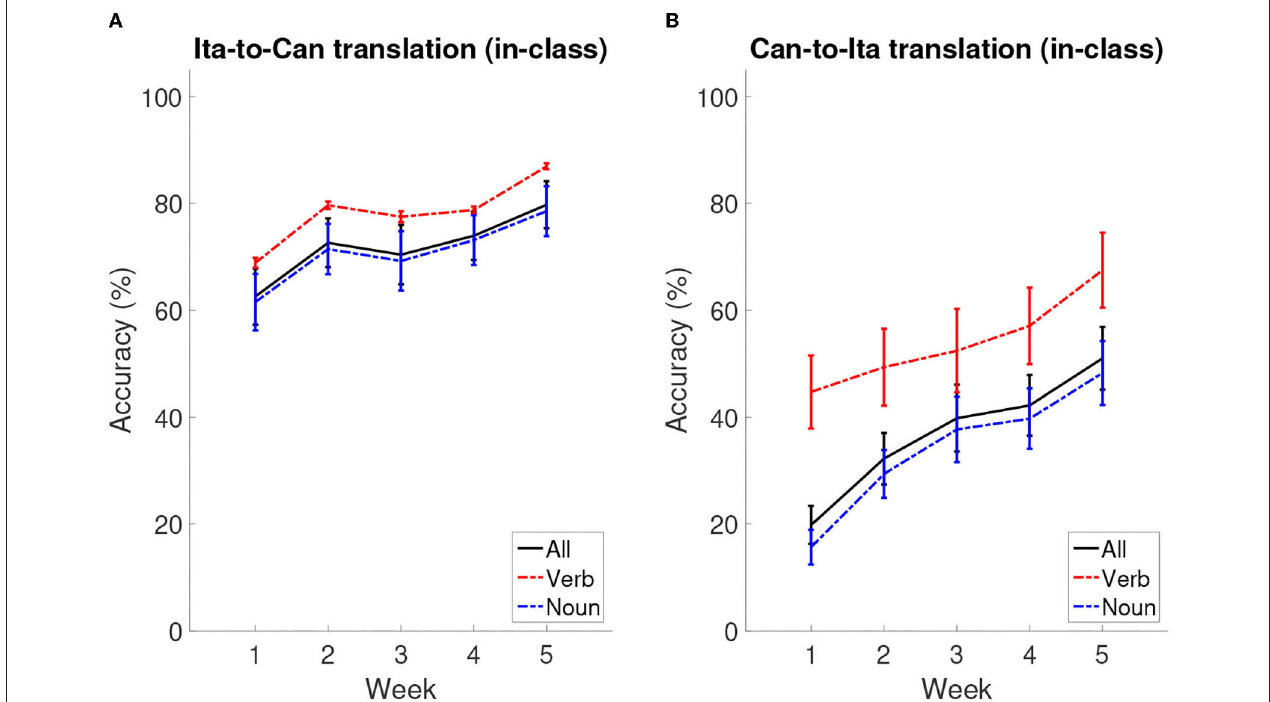
FIGURE 3 | Learning curves across the five weeks. (A) The accuracy of Ita-to-Can translation across weeks. (B) The accuracy of Can-to-Ita translation across weeks. Solid lines: overall in-class learning performance as a function of week; dotted lines: the scores for the verb and noun components, separately plotted to reflect the structure of the in-class quizzes. The error bars represent standard error means.